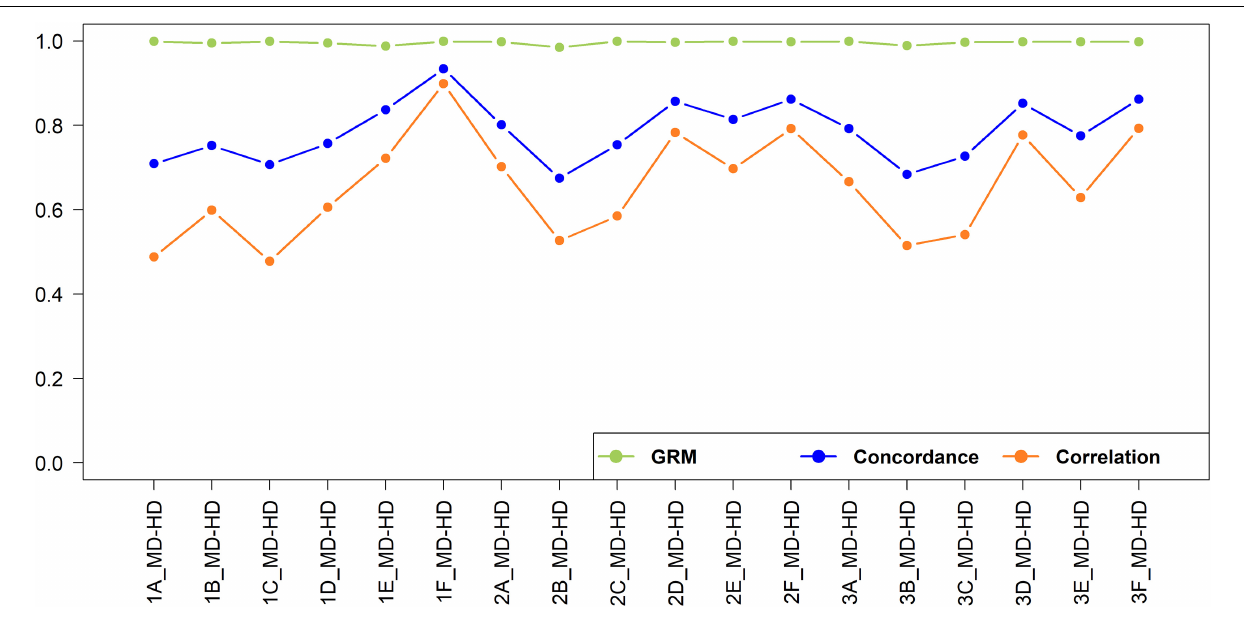
FIGURE 10 | Genotype imputation accuracy and GRM correlation between real and imputed genotypes for imputation from medium to high-density.